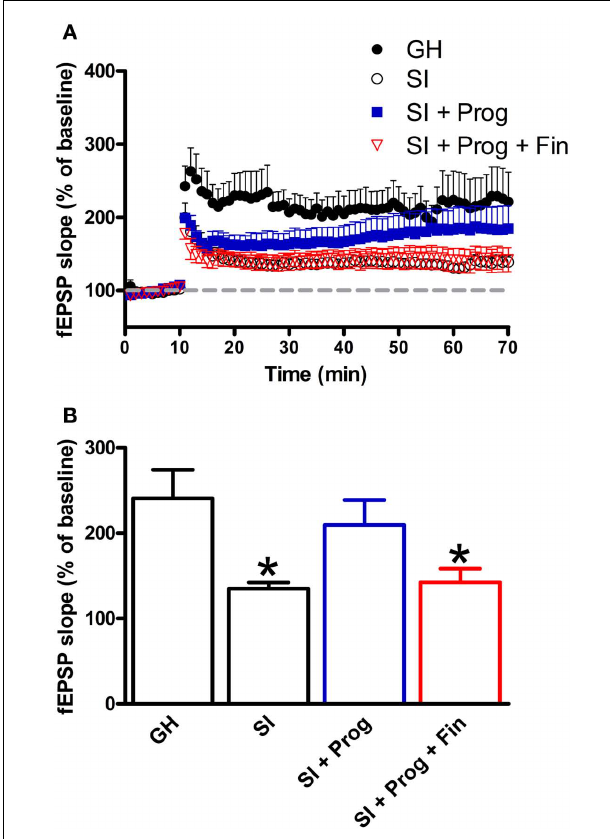
FIGURE 4 | Reversal of the effect of SI on LTP in the CA1 region by progesterone treatment: effect of the co-treatment with progesterone and finasteride. (A) LTP was induced in the CA1 region by HFS (arrow) of the Schaffer collateral–CA1 pathway in hippocampal slices obtained from GH mice as well as from SI mice that had been treated or not with progesterone. Data represent fEPSP slope at the indicated times expressed as a percentage of that at baseline and are means ± SEM ( n = 6–10 slices). (B) The extent of LTP was calculated by averaging the change in fEPSP slope apparent between 50 and 60min after HFS. Data are means ± SEM ( n = 6–10 slices). * p < 0.05 vs. GH